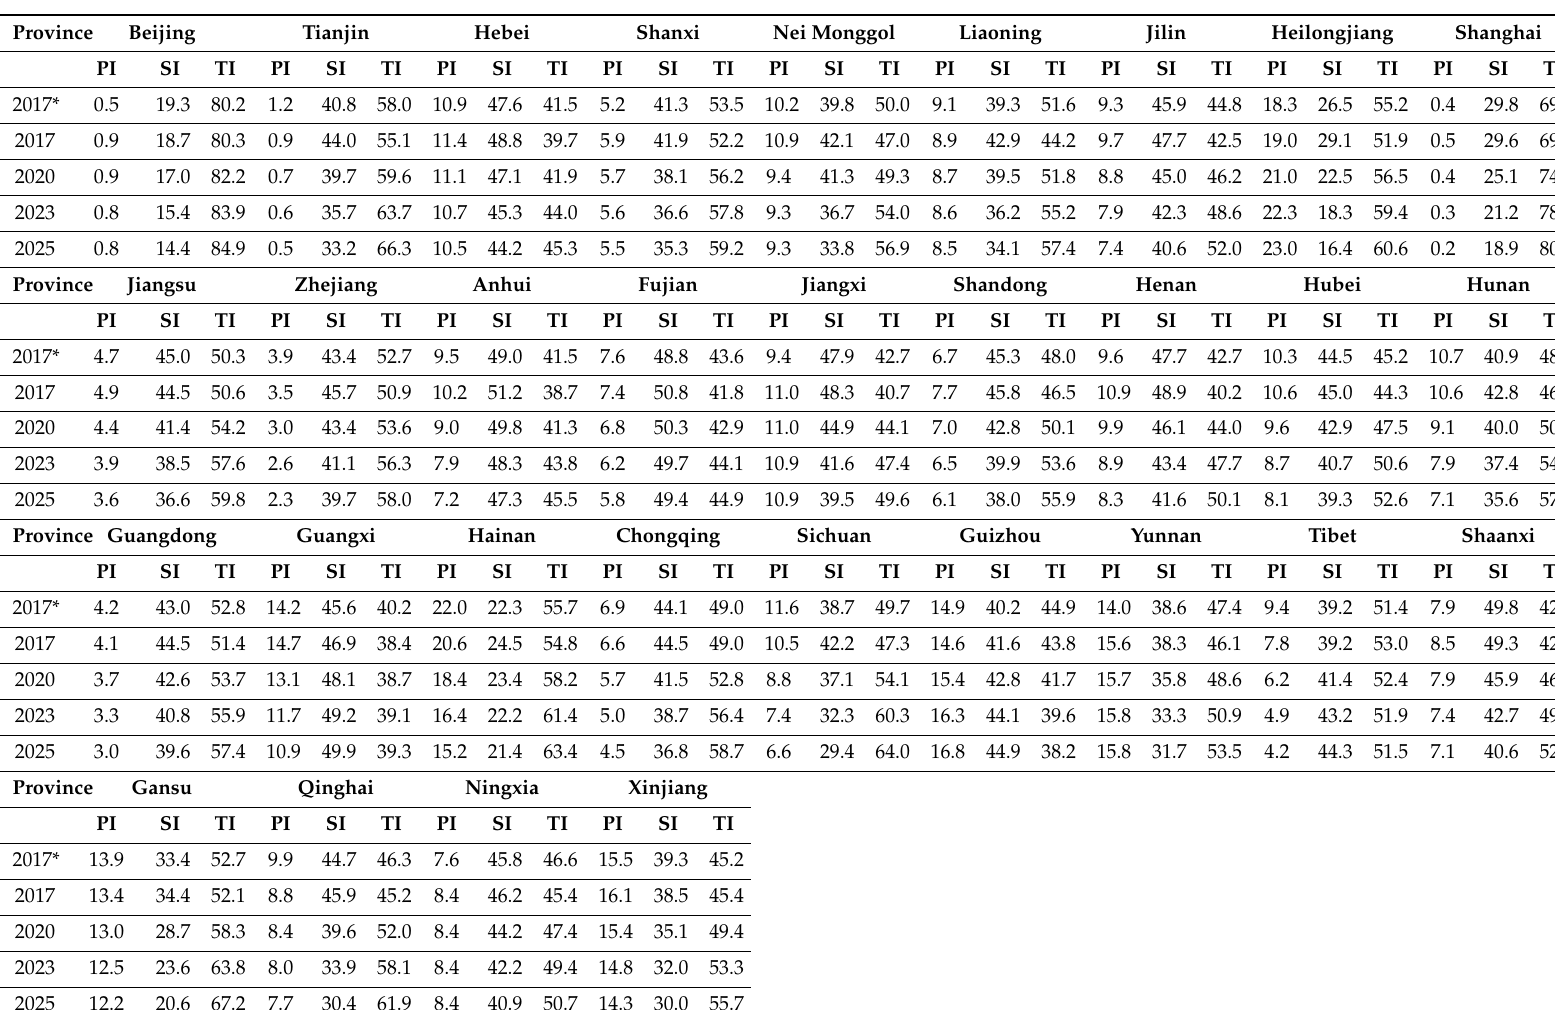
Table A3. Industry structure of di ff erent provinces in 2017, 2020, 2023, and